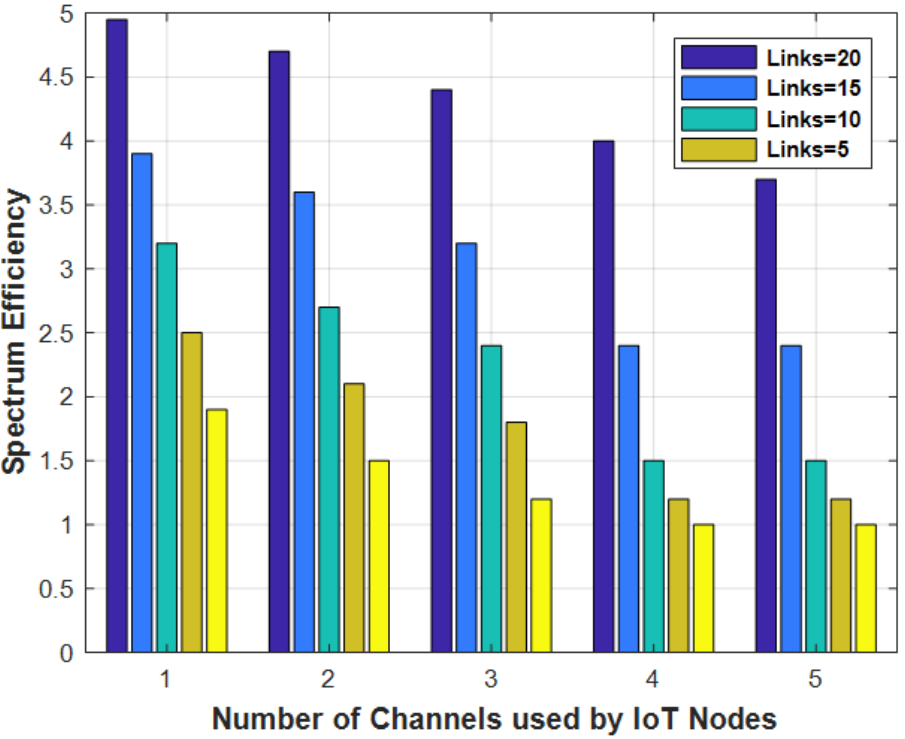
Figure 5. Spectrum efficiency with varying number of channels.